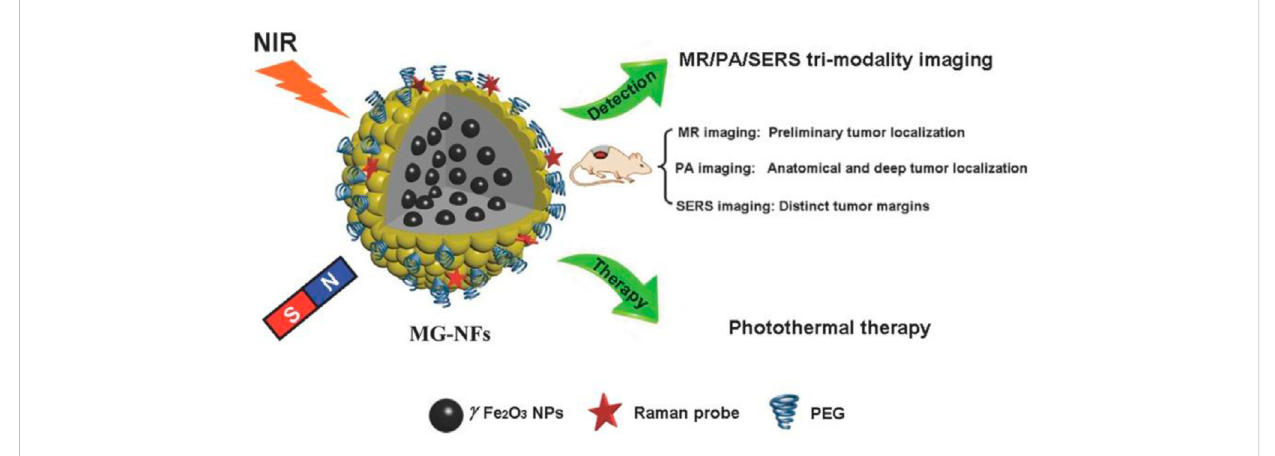
FIGURE 10 The illustration of magnetic gold nano fl owers (MG-NFs) with a core/shell of γ Fe 2 O 3 @Au for tumor photothermal therapy and multimodal imaging. Reproduced with permission from reference (Huang et al.,